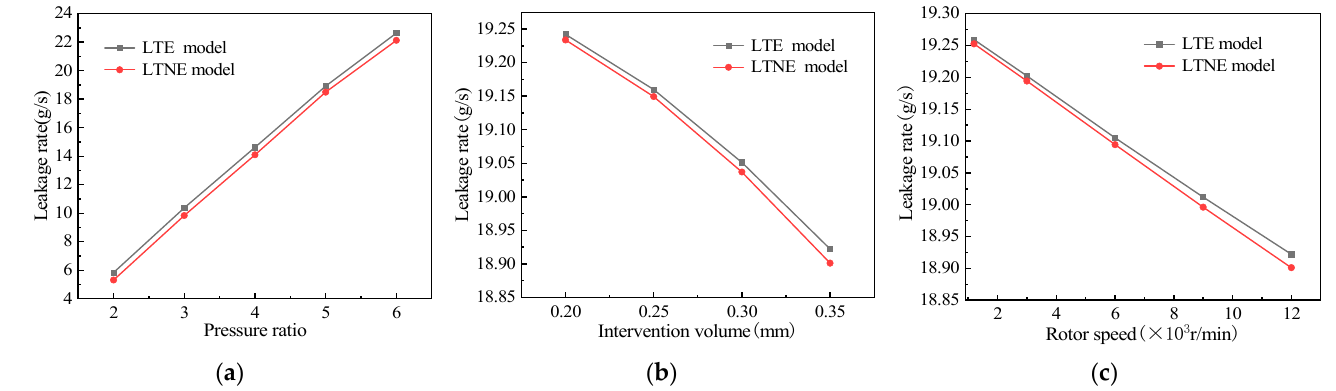
Figure 12. Variation of the leakage rate with pressure ratio ( a ), interference amount ( b ), and rotational speed ( c ).